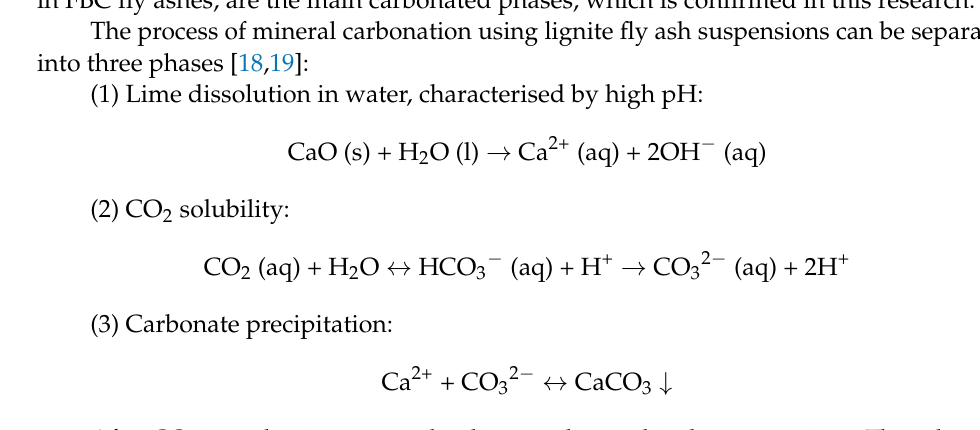
Table 3. Main products of hydration and carbonation of ash–water suspensions. PF